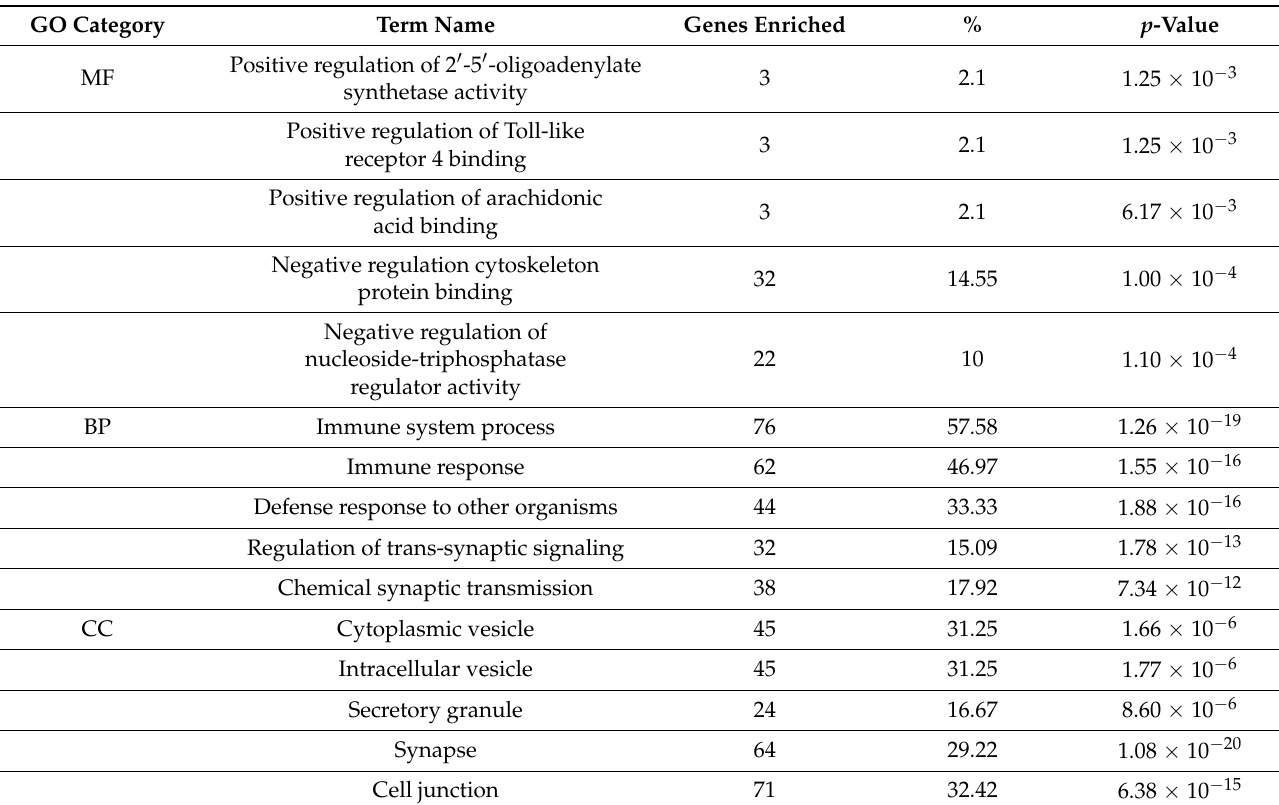
Table 1. Gene ontology signatures of differentially expressed genes associated with SARS-CoV-2– GBM